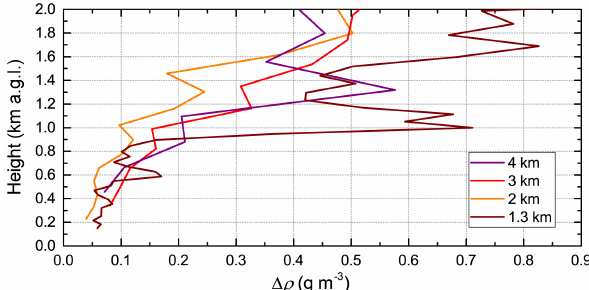
Figure 5. Instrumental noise profiles of the RHI scans shown in Fig. 6 for horizontal distances (range resolution) of 1.3km ( (cid:49)R = 142 . 5m), 2km ( (cid:49)R = 307 . 5m), 3km ( (cid:49)R = 497 . 5m), and 4km ( (cid:49)R = 997 . 5m) with a temporal resolution of